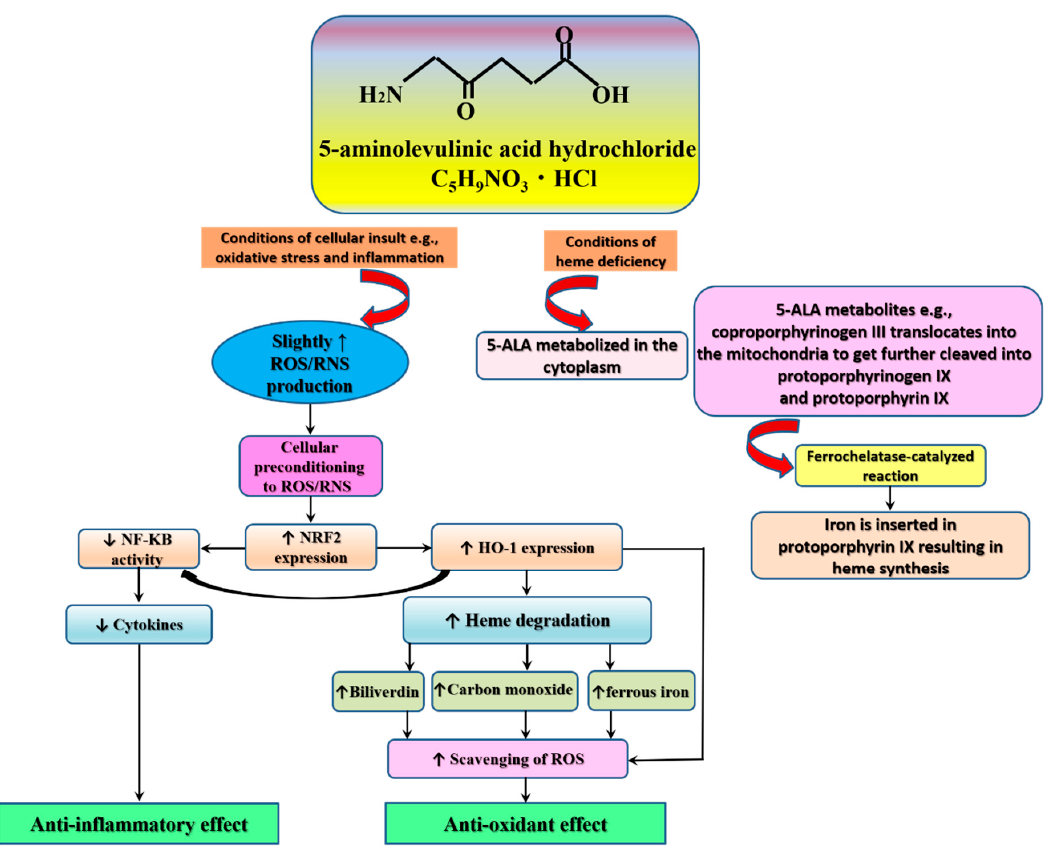
Figure 4. The possible mechanism of action of 5-aminolevulinic acid. Abbreviations: ROS, reactive oxygen species; RNS, reactive nitrogen species; NRF2, nuclear factor erythroid 2; HO-1, heme oxygenase-1; NF-kB, nuclear factor kappa light chain enhancer of activated B cells.